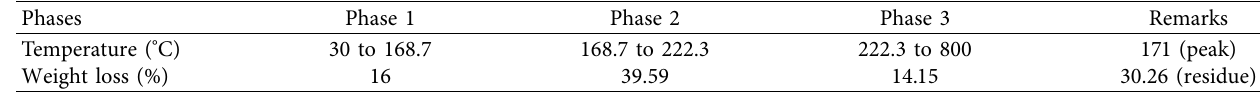
Table 1: Different stages of the TGA for Gracilaria fisheri in N